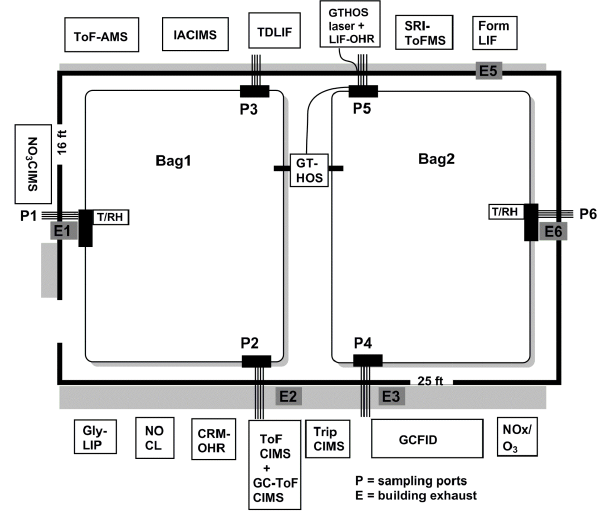
Figure 2. Arrangement of instruments at the Caltech Atmospheric Chamber Facility during the campaign. Instrument IDs are in Ta- ble